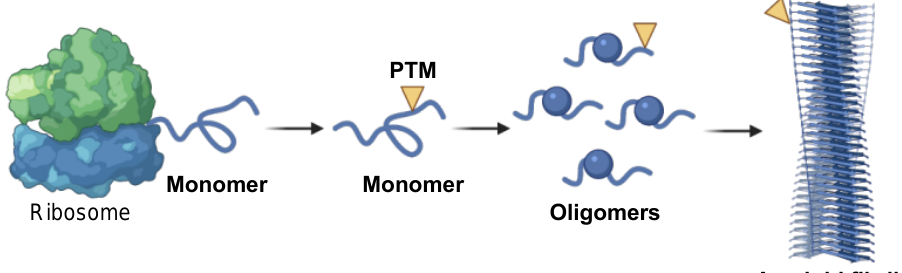
Figure 1. Schematic representation of amyloid aggregation. In normal conditions, proteins are newly synthesized on ribosomes and released to play biological functions. In stress conditions or as a consequence of pathological post-translational modifications (PTMs), these proteins can assemble into small soluble oligomers and ultimately form insoluble amyloid fibrils. PTMs may occur at any state of this process, affecting the formation, stability and toxicity of these aggregates. Oligomers are toxic by a multitude of mechanisms including aberrant hydrophobic interactions. It has been shown that, in tissue and isolated cells, oligomers can affect membrane permeability, ion homeostasis, and induce oxidative stress [16,21–23]. Oligomer- induced free radicals can then trigger protein misfolding, mitochondrial dysfunction and eventually apoptosis [24]. Oligomers of A β and α -syn have also been associated with neuroinflammation [22] and synapsis loss